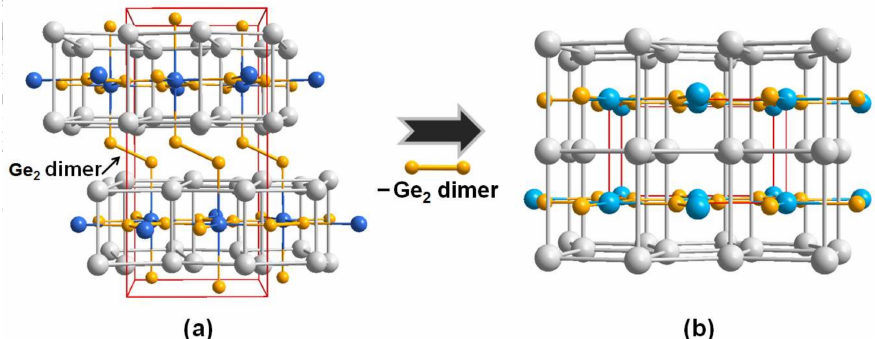
Figure 2. Schematic illustration showing the structural correlation between ( a ) the RE 4 LiGe 4 ( RE = La, Ce, Pr, Sm) system and ( b ) the RE 2 In 1 − x Li x Ge ( RE = La, Nd, Sm, Gd; x = 0.13(1), 0.28(1), 0.43(1), 0.53(1)) system. A unit cell of each structure type is outlined in red, and the both of the interlayer and intralayer Ge 2 dimers are highlighted in orange-color. Color codes: RE , gray; Ge, orange; In/Li mixed-site, blue.